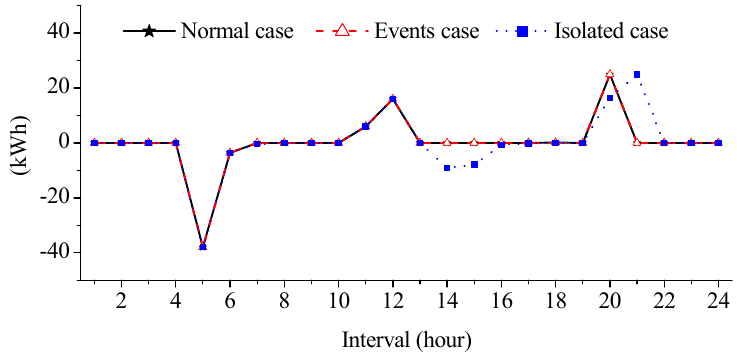
Figure 15. Comparison of the amount of power exchange with the utility grid.